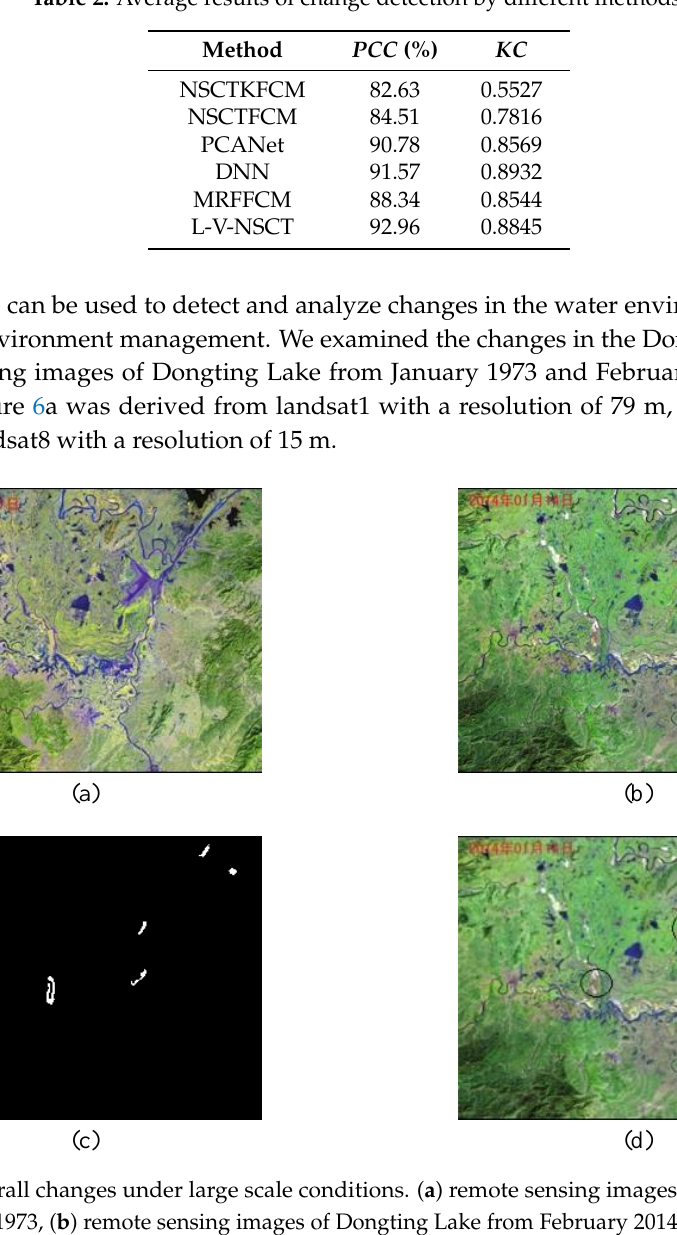
Table 2. Average results of change detection by different methods.